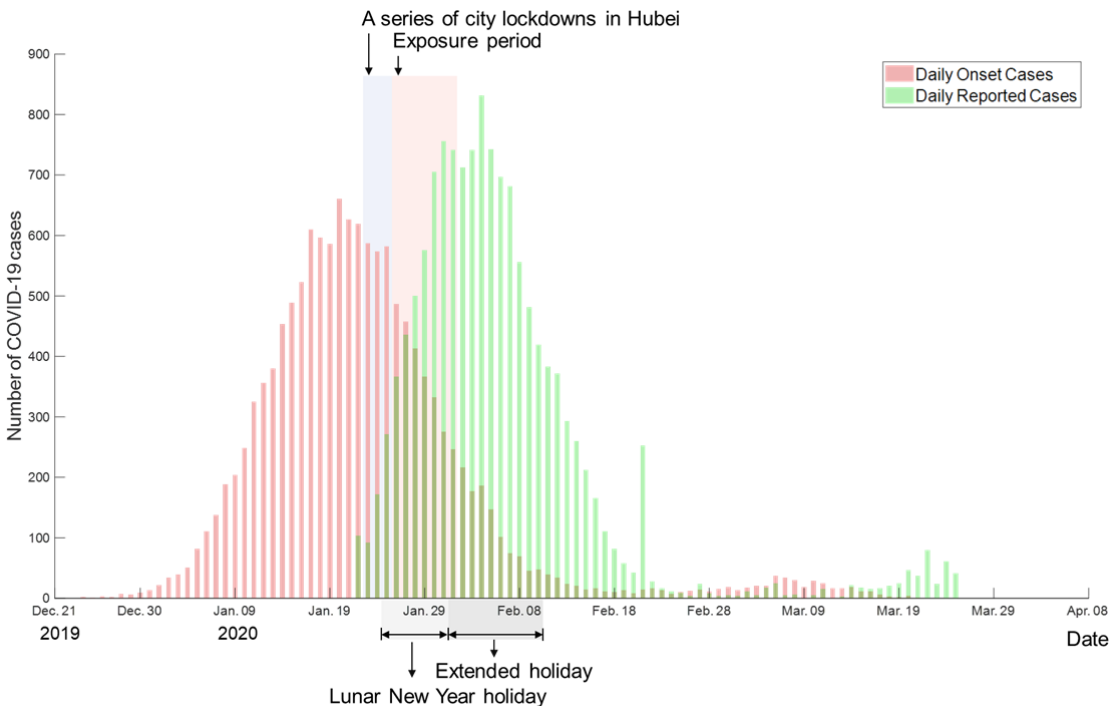
Figure 1. The timeline of pandemic transmission in mainland China (Hubei province was excluded).